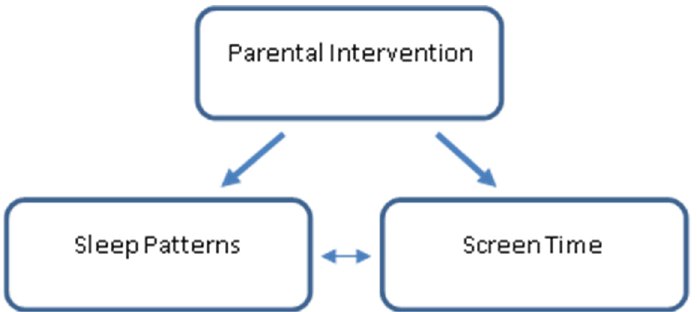
Figure 1. Theoretical model of this